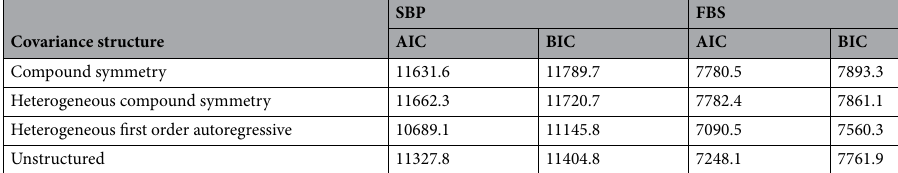
Table 3. Comparison of the covariance structure of a linear mixed effect model. AIC Akaike information criteria, BIC Bayesian information criteria, SBP Systolic blood pressure, FBS Fasting blood sugar.